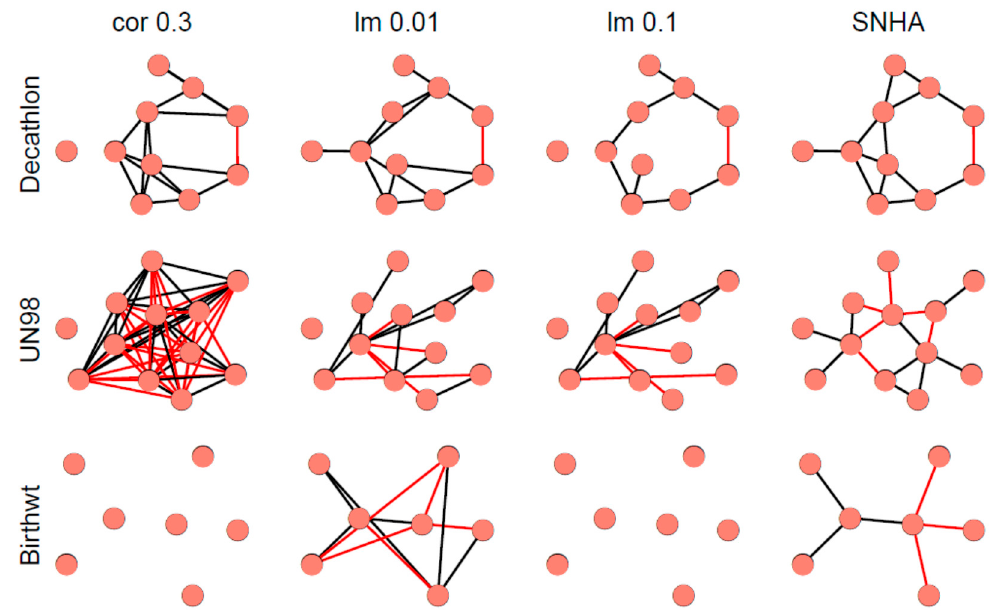
Figure 7. Network graphs derived from sample 1 (Decathlon), sample 2 (UN98), and sample 3 (Birthweight). After excluding non-significant associations ( p > 0.05) and associations with a predicted R 2 value of less than 10% and 1%, we created networks by pairwise correlations at a threshold correlation coefficient of |r| > 0.3 (left); by linear models using forward selection for each variable, at two thresholds of R 2 < 0.01 (lm 0.01) and R 2 < 0.10 (lm 0.1); and by SNHA. Black edges indicate positive, red edges indicate negative correlations.